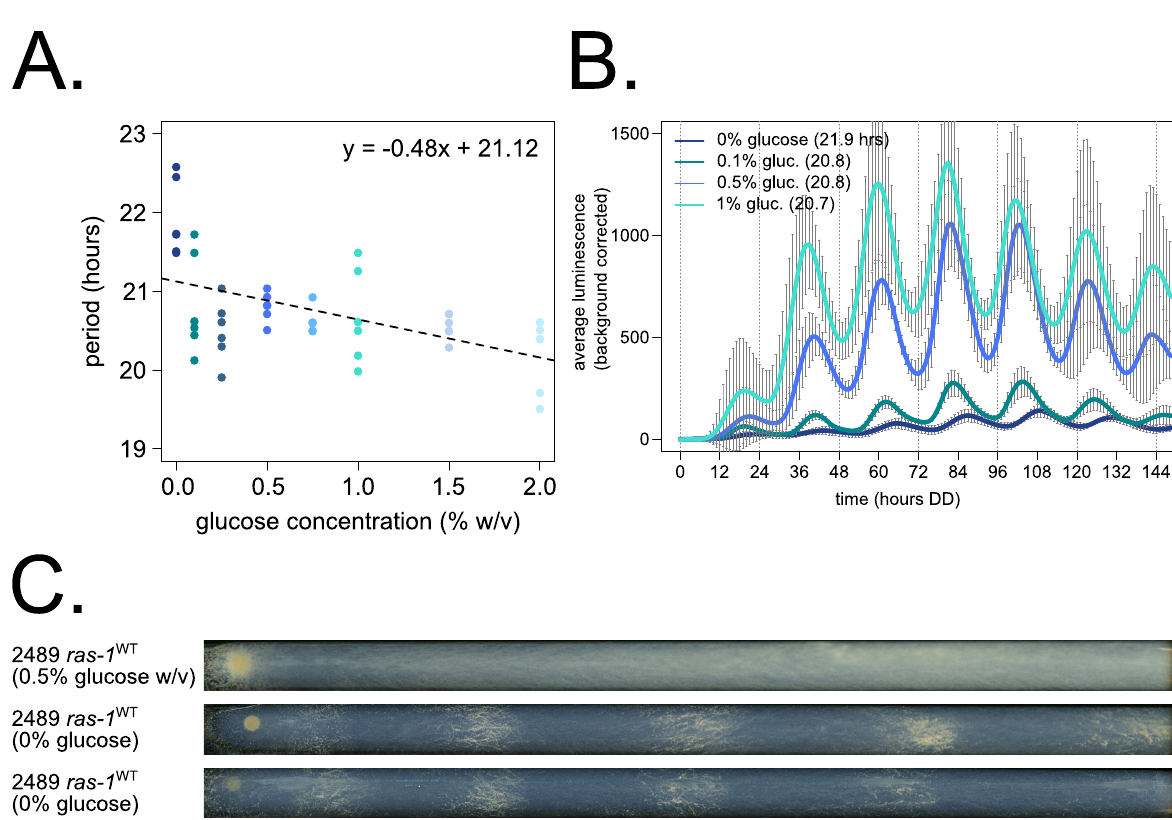
Fig 1. Nutritional Compensation properties of Neurospora crassa . Circadian period length was determined by bioluminescent recordings of a ras-1 WT strain cultured on race tubes, where the fungal growth front encounters constant glucose concentrations ( N = 6 race tubes per concentration). No arginine was added to the medium. Period shortens slightly as a function of glucose levels, which is indicated by the negative slope of the linear fit (glm in R, Gaussian family defaults, slope = − 0.48 ± 0.12) ( A ). Averaged biological and technical replicates are shown for 0 mM (0% w/v), 5.6 mM (0.1% w/v), 27.8 mM (0.5% w/v), and 55.5 mM (1% w/v) glucose levels (standard deviation error bars). Period lengths are 21.9 ± 0.5, 20.8 ± 0.6, 20.8 ± 0.2, and 20.7 ± 0.6 hours, respectively (average ± SD) ( B ). Surprisingly, the ras-1 WT strain can form distinct conidial bands when grown on 0% glucose starvation medium, contrasted with constitutive conidiation seen at high glucose levels ( C ). The raw data underlying parts ( A ) and ( B ) can be found in S1